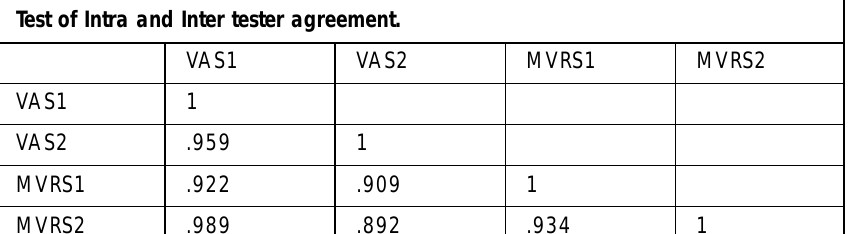
Table 4: Correlation Matrix of OA Pain ratings with Visual Analogue Scale and with Modified Verbal Rating